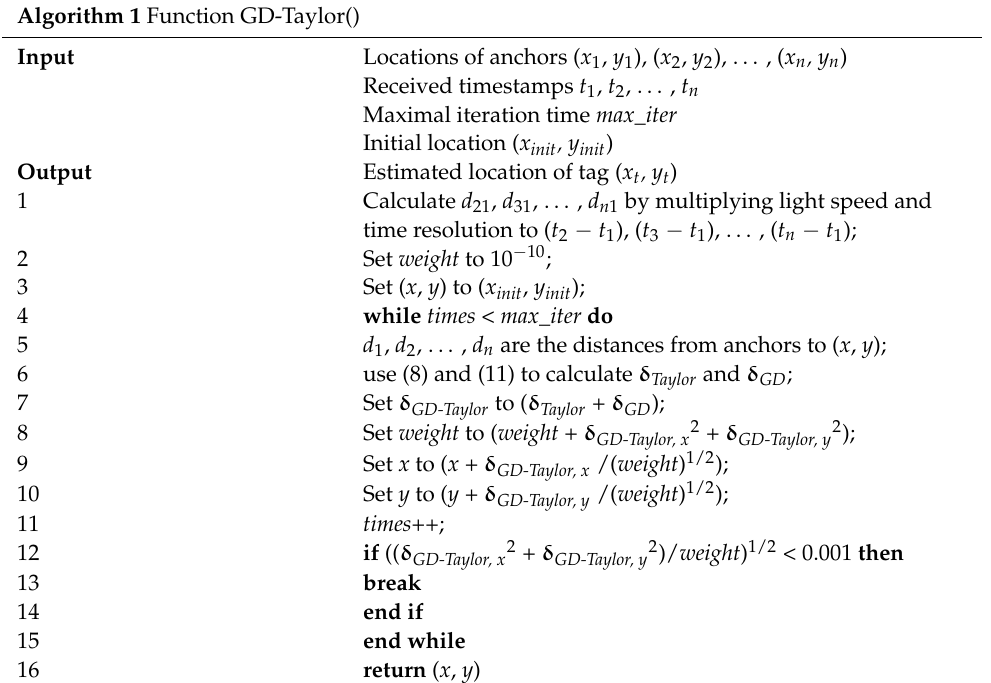
Algorithm 1 Function